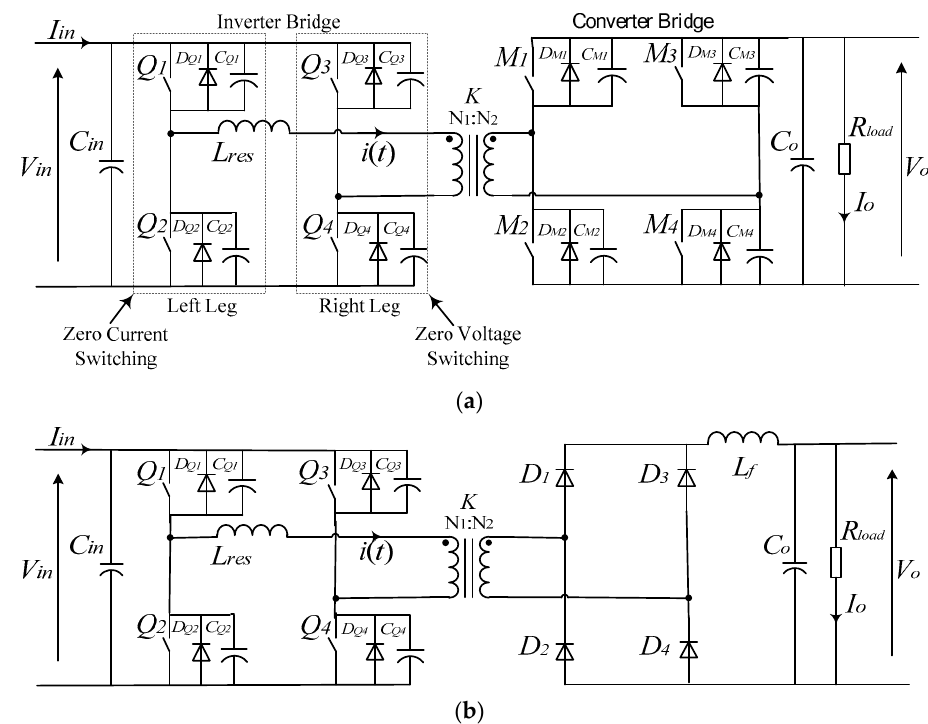
Figure 1. ( a ) Topology of the Bi-directional Phase-Shift-Controlled DC-DC Converter; ( b ) Topology of a Conventional Phase-Shifted Converter.